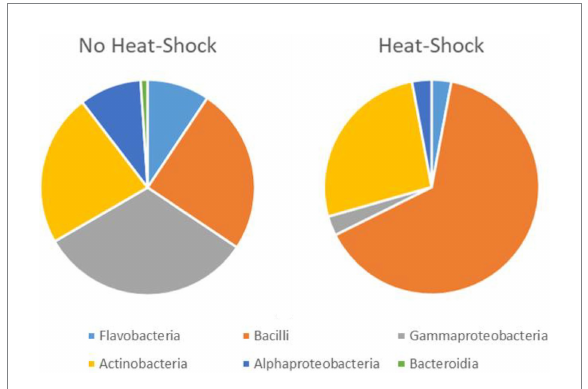
FIGURE 5 Effect of heat shock treatment on the isolation of spore forming bacteria. The total number of isolates is 68 after heat shock and 194 without heat shock. However, the quantitative representation of the bacterial groups varies significantly between heat shock and control.